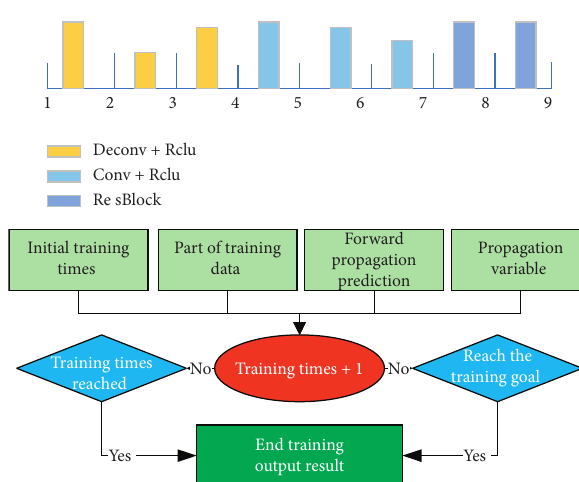
Figure 3: Schematic diagram of the dot product